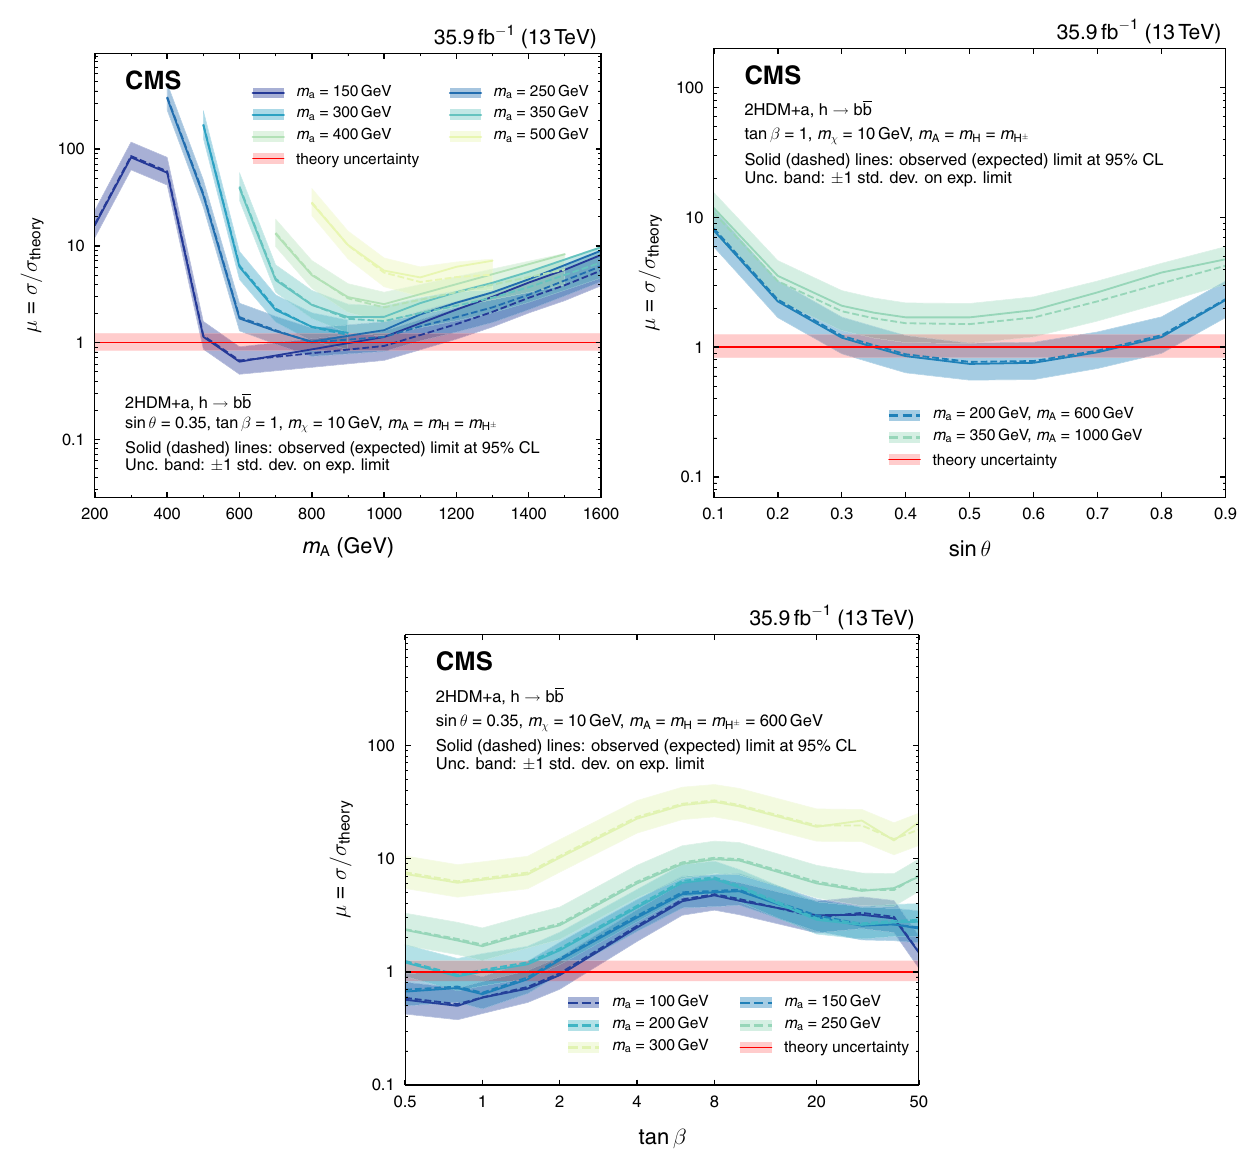
Fig. 6 Upper limits at 95% CL on the signal strength modifier, defined as μ = σ/σ theory , where σ theory is the predictedproduction cross section of DM candidates in association with a Higgs boson and σ is the upper limit on the observed cross section. Limits are shown for the 2HDM+a